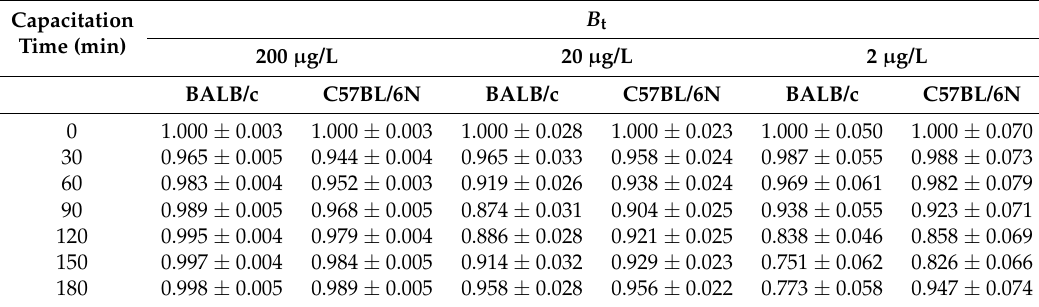
Table 1. Relative concentrations of total unbound estradiol ( B t ) calculated from the measured time-dependent concentrations of total unbound estradiol ( C ) (Figure 1A–C) obtained during capacitation for three tested estradiol concentrations and two inbreed mouse strains; mean ± standard error of the